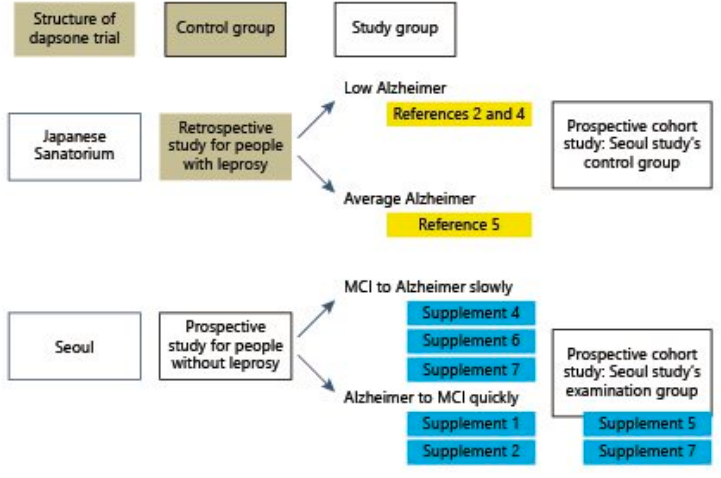
Figure 2. Structure and result of prospective cohort.